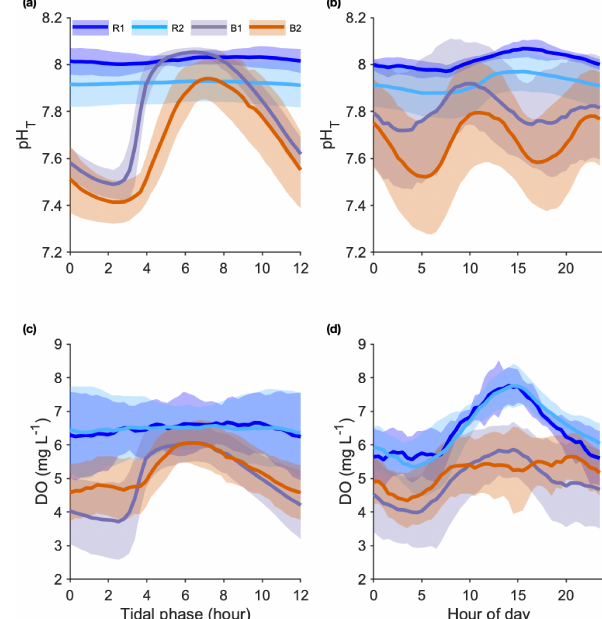
Figure 4. Seawater pH T (a, b) and dissolved oxygen (DO) (c, d) variations recorded at the reference (Sts R1 and R2) and Bouraké (Sts B1 and B2) reefs. Data were overlaid at a single tidal phase (12h) (a, c) and at a 24h cycle (b, d) . Data are 22, 72, 31, and 72 semidiurnal tidal cycles for pH and 36, 79, 34, and 42 semidiurnal tidal cycles for DO, for R1, R2, B1, and B2,